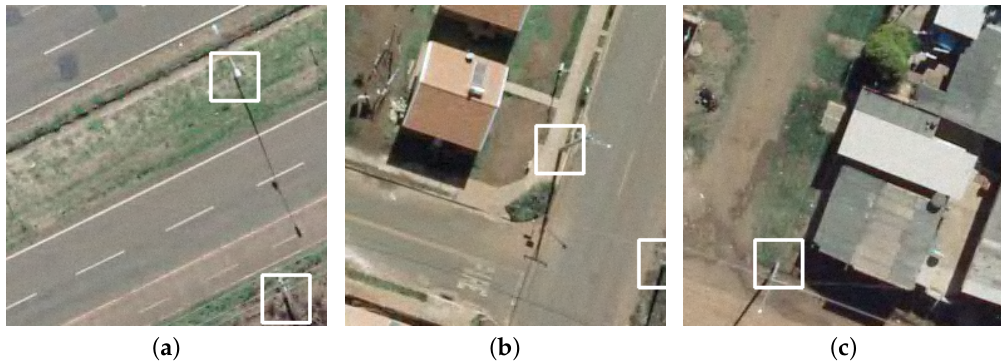
Figure 9. Examples of utility poles that are not fully cover with a 40 × 40 bounding box size: ( a ) example 1; ( b ) example 2; and ( c ) example